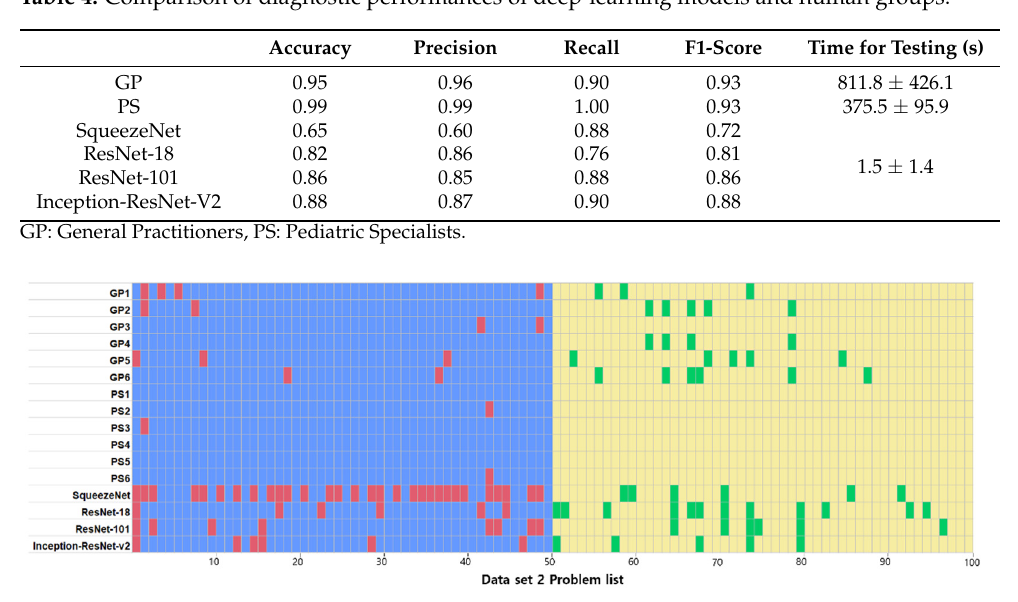
Figure 6. Differences in answers between human evaluators and deep-learning models on dataset 2. Blue: true positive, Red: false negative, Yellow: true negative, and Green: false positive. GP: General Practitioners, PS: Pediatric Specialists.